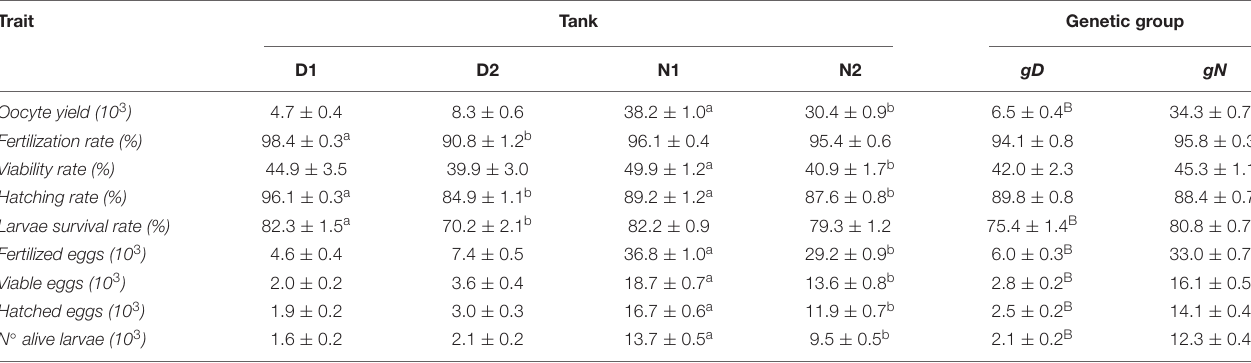
TABLE 1 | The mean values of spawning quality traits throughout the spawning season ( oocyte yield, fertilization rate, viability rate, hatching rate, larvae survival rate, fertilized eggs, viable eggs, hatched eggs, number of alive larvae ) per Tank (D1, D2, N1, N2) and per Genetic group ( gD , gN ). Trait Tank Genetic